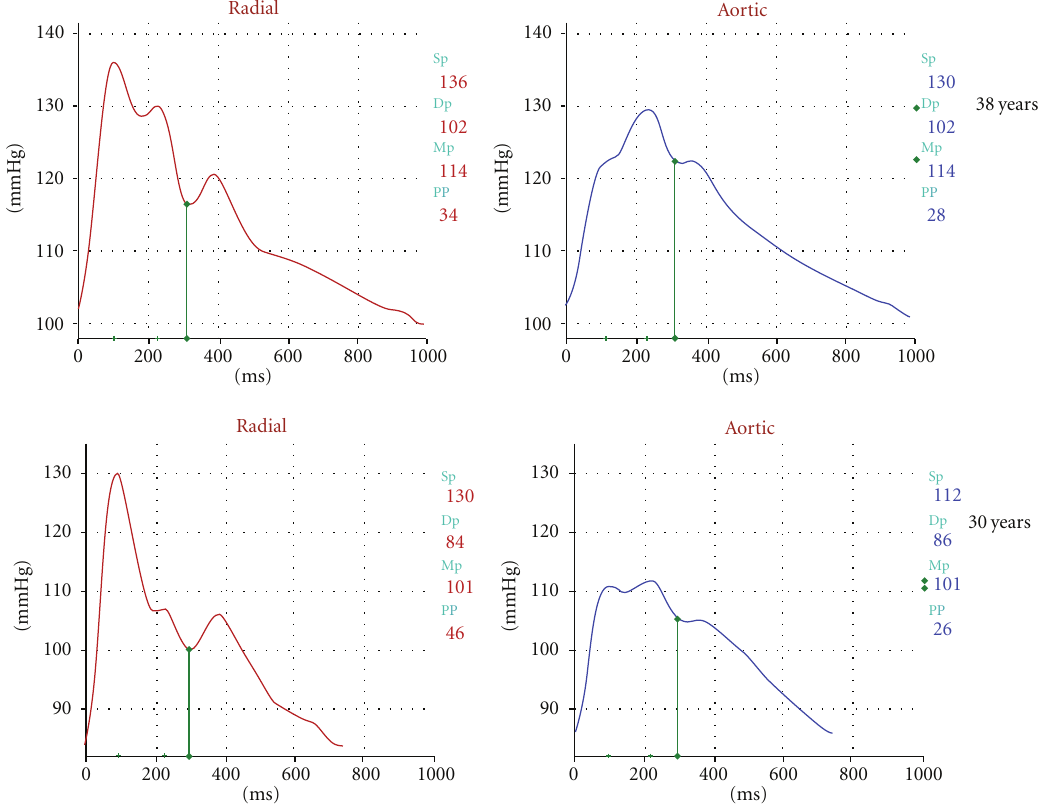
Figure 4: Representative wave forms showing the e ff ect of aging on the radial (left) and aortic (right) pulse contours from subjects studied in the